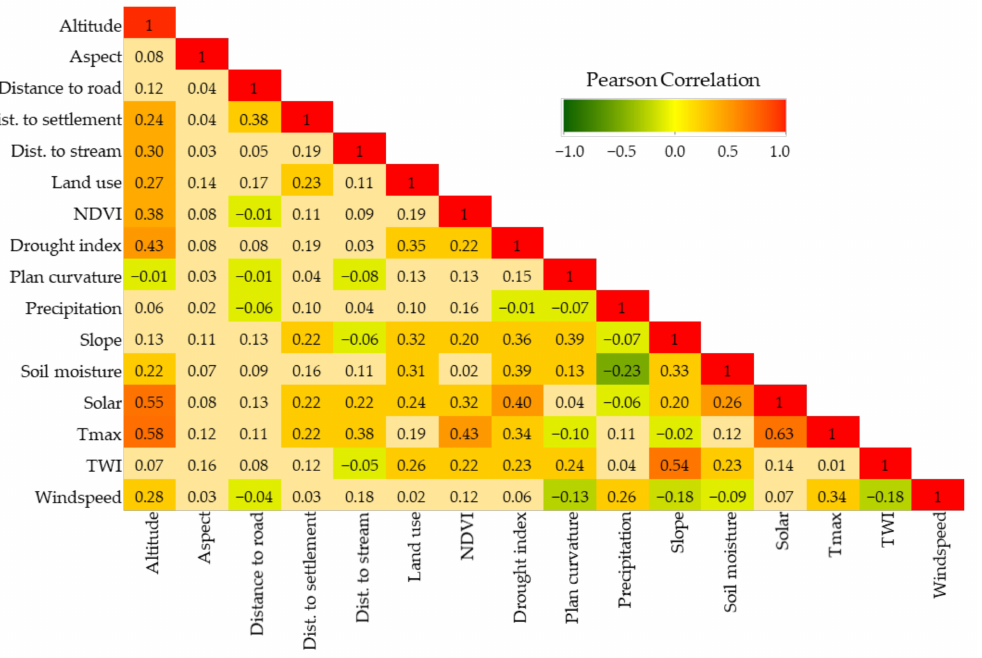
Figure 6. Pearson correlation between wildfire conditioning